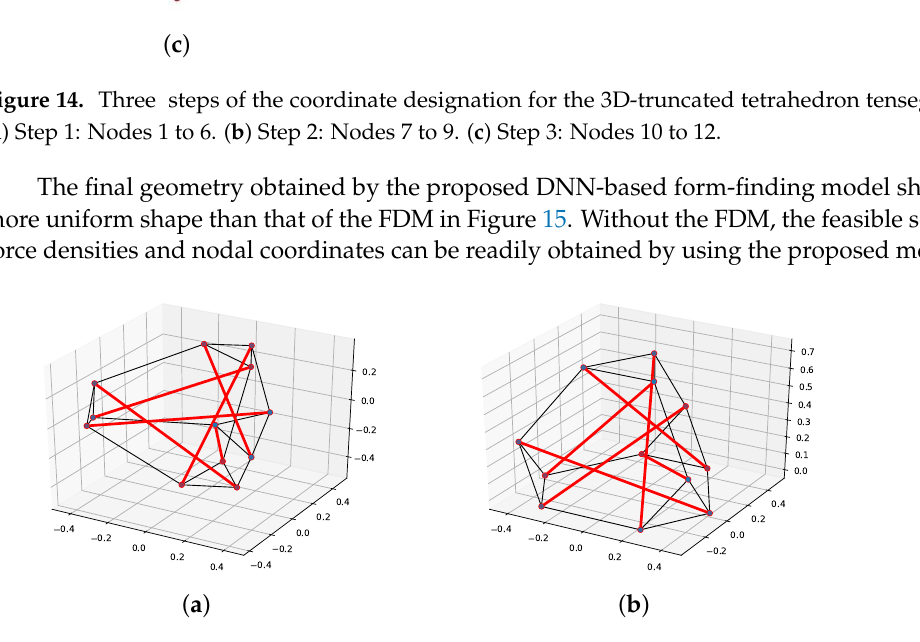
Figure 15. Final geometry of five iterations of the 3D truncated tetrahedron tensegrity using an FDM and a DNN-based form-finding model with a DE algorithm. ( a ) FDM. ( b ) DNN-based form-finding